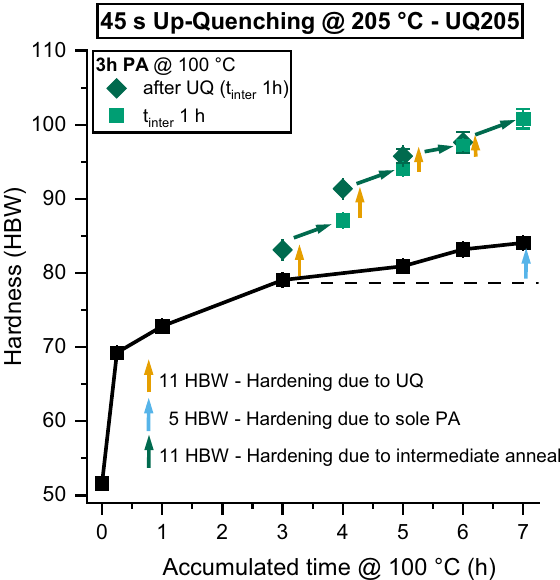
Fig. 6 Acceleration of hardening during annealing at 100 °C via up- quenching at 205 °C. A gradual hardness evolution upon up-quenching the samples at 205 °C for 45 s and 1 h of intermediate annealing after 3 h of pre-annealing is shown. The three numerical hardness values represent the total hardness increase triggered by the different treatments (illustrated by differently coloured arrows). Due to the decreased up-quenching- temperature of 205 °C, hardness increases due to each up-quenching (orange arrows, 11 HBW). However, compared to sole pre-annealing (blue arrow, 5 HBW), up-quenching causes increased hardening during the subsequent intermediate annealing steps (green arrows, 11 HBW). “ PA ” stands for pre-annealing. The error bars for each hardness measurement were determined from at least fi ve hardness indents and represent one standard